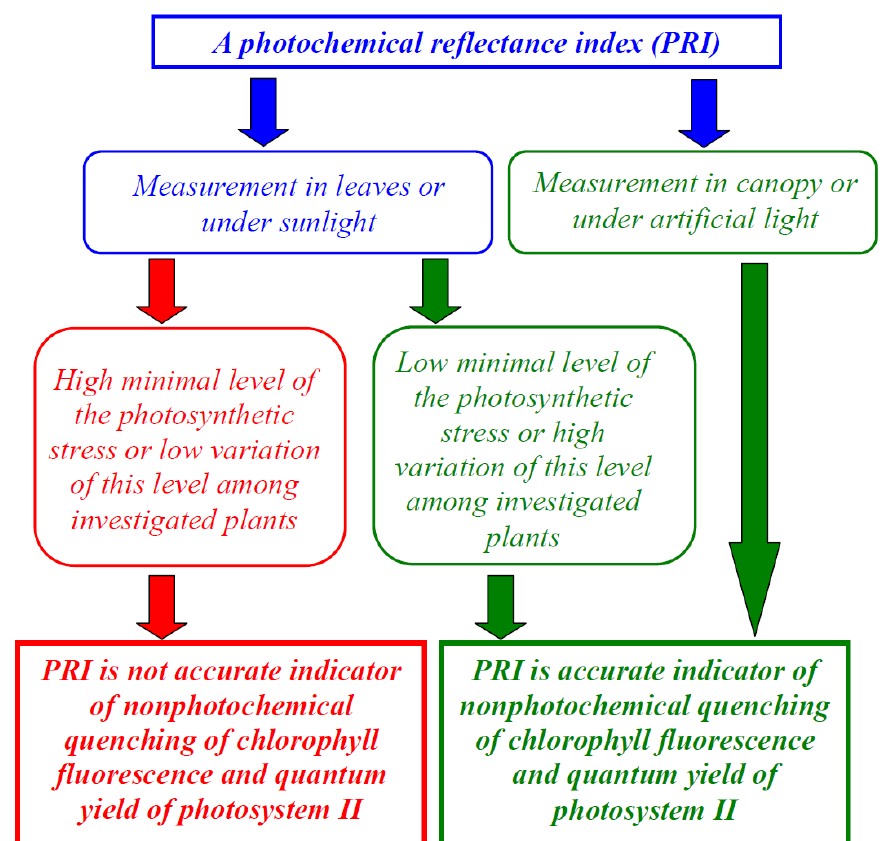
Figure 8. An expected efficiency of application of PRI for investigation of NPQ and ∆ F/F m ’ at different conditions of measurements and different distribution of photosynthetic stress levels among investigated plants.